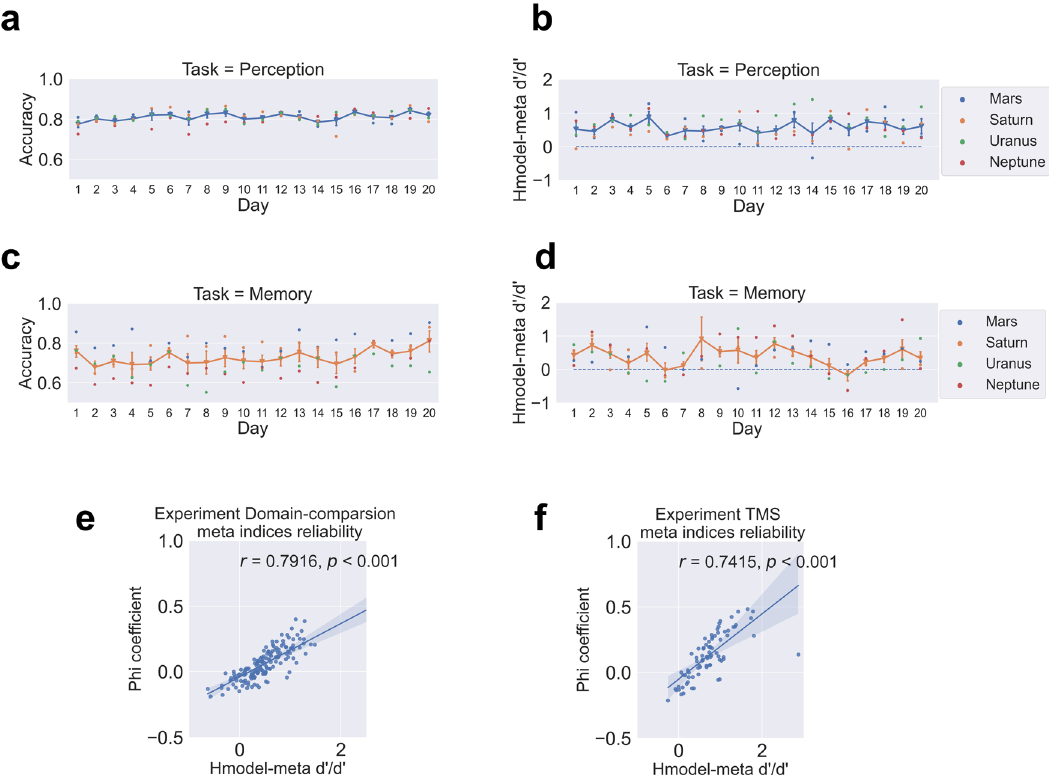
Fig. 1 Task performance and metacognitive capability remained steady across days. Plots depict daily accuracy ( a , c ) and metacognitive ef fi ciency ( b , d ) across 20 days for four monkeys performing two tasks. Strong correlations between the two meta-cognitive metrics ( e , f ). Pearson correlations computed among the two meta-indices were statistically signi fi cant (both P s < 0.001). Error bars indicate ± one standard error.